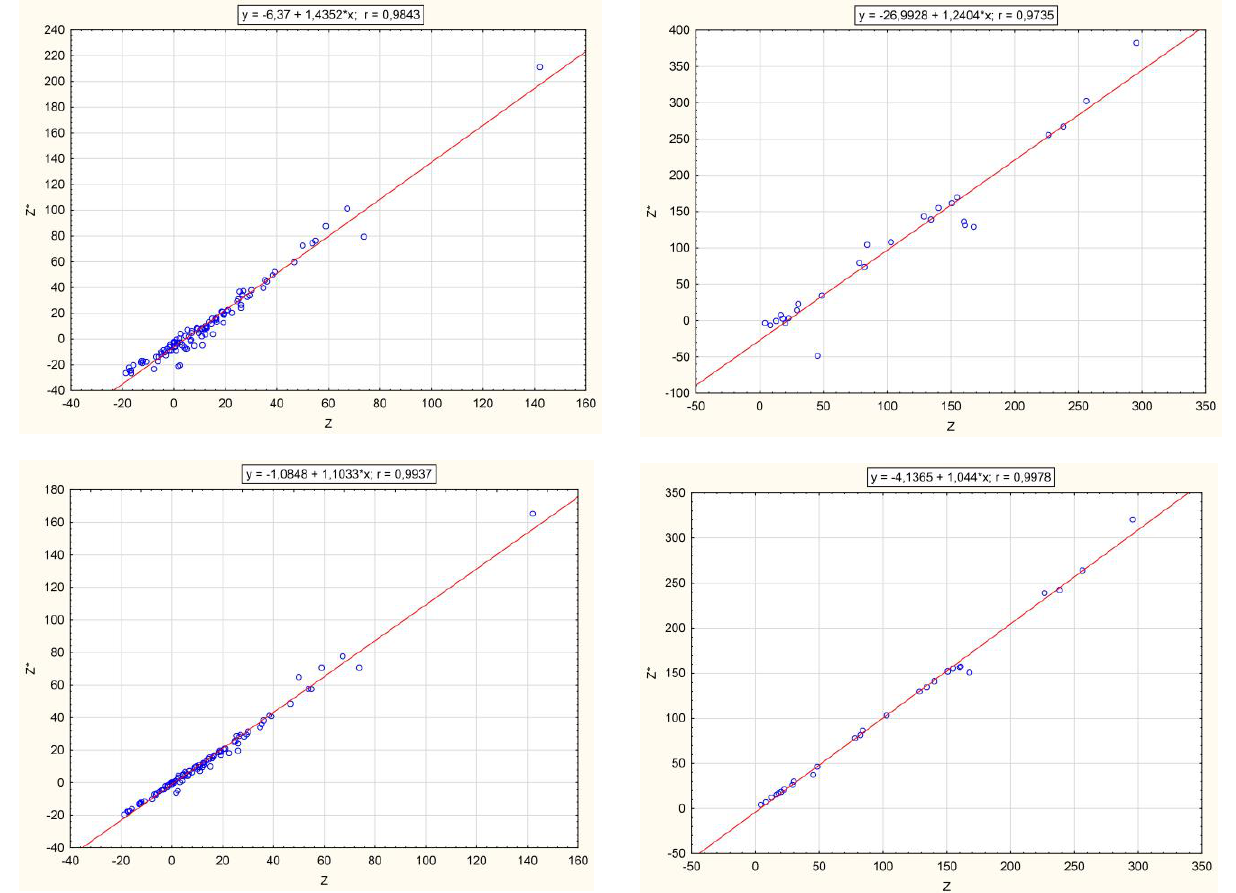
Fig. 5. A dispersion diagram of the real (Z) and estimated (Z*) values obtained by means of IDW and RBF within the "Wojkowice" spoil tip: A – for points located on the surface of the heap, application of IDW; B – for points located on the surface of the heap, application of RBF; C – for points located inside the heap, application of IDW; D – for points located inside the heap, application of RBF